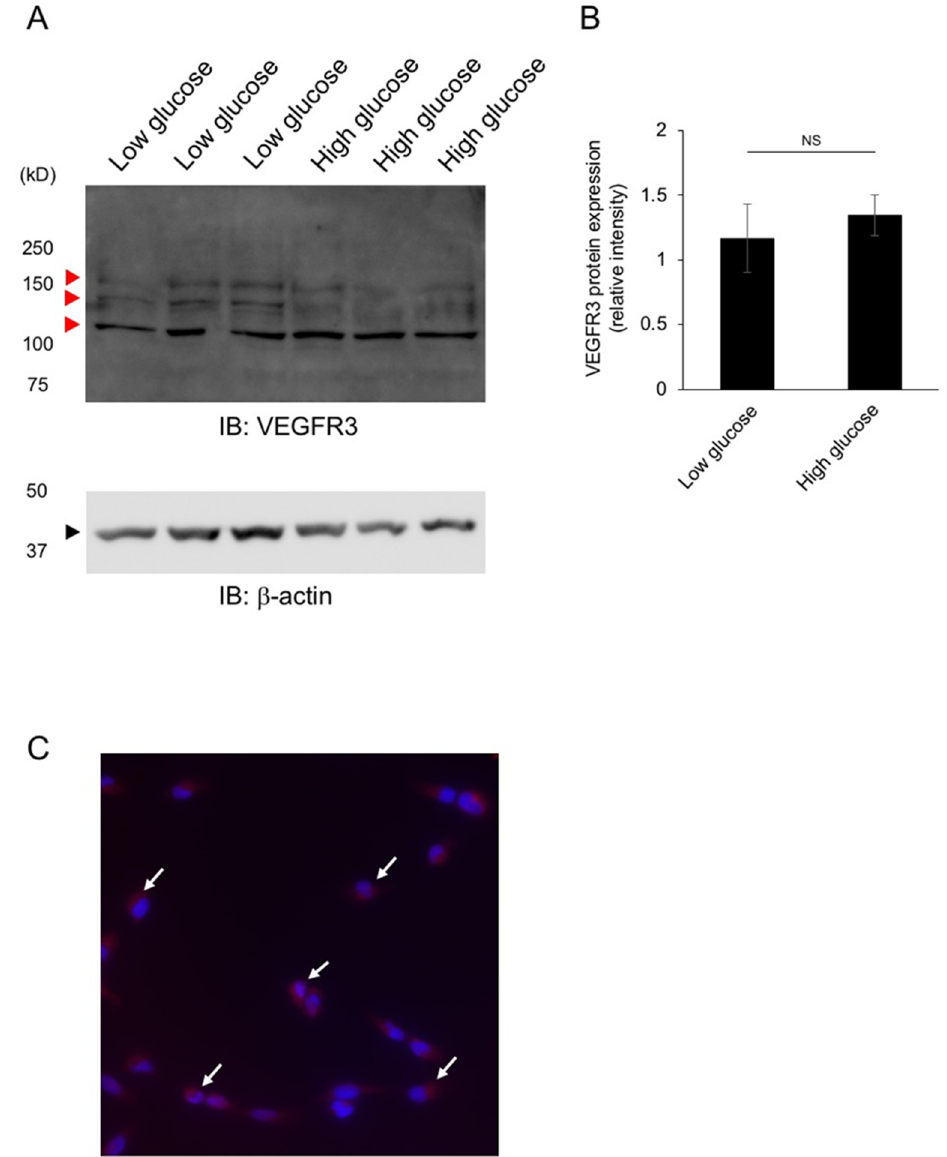
Figure 6. Western blot analysis and immunocytochemistry of trabecular meshwork cells for vascular endothelial growth factor receptor (VEGFR)3. VEGFR3 (red arrowhead) and β -actin (black arrowhead) were detected in the cell lysates of trabecular meshwork cells cultured in low and high glucose media ( A ). Densitometry values of VEGFR3 normalized to β -actin ( n = 3 in each group) ( B ). There was no significance in band intensity between low glucose media and high glucose media ( p > 0.05). Immunocytochemistry for VEGFR3 in trabecular meshwork cells. Cytoplasmic immunoreactivity for VEGFR3 (red, white arrows) was noted with DAPI nuclear staining (blue) ( C ).